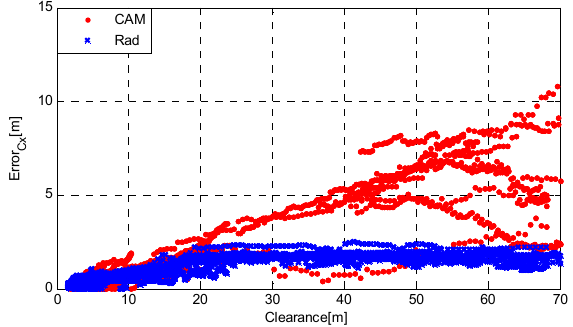
Figure 1. Range Error vs. Range of Radar and Camera (Vision sensor).